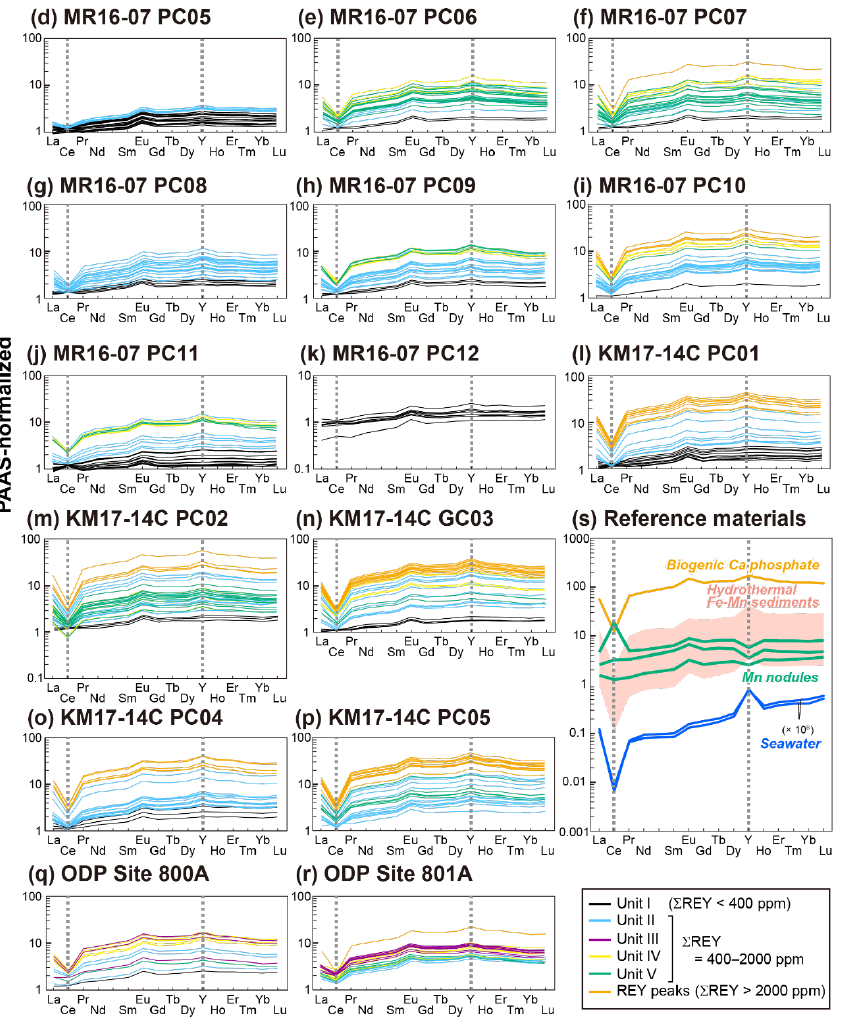
Figure 3. Post-Archean average Australian shale (PAAS; [30])-normalized REY pattern of all the